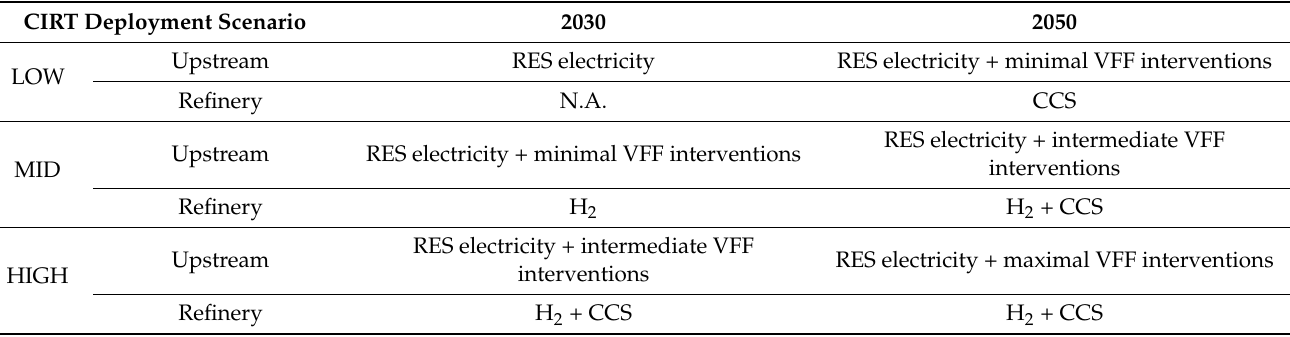
Table 4. Summary of the CIRT applied in the considered scenarios across the evaluated timeframe. CIRT Deployment